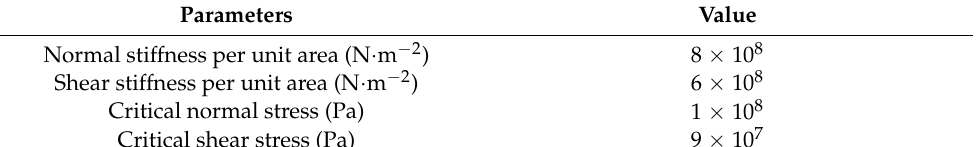
Table 1. Parameters of bonding bonds.